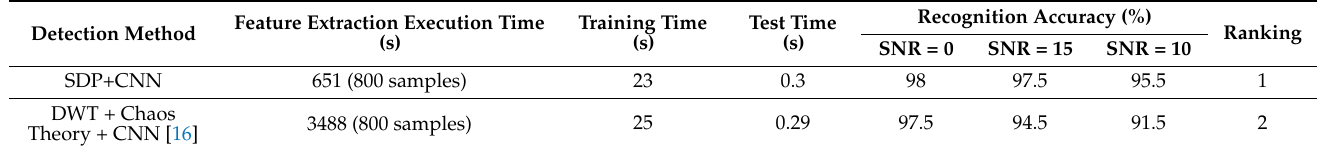
Table 3. Comparison results of the proposed method and Ref.